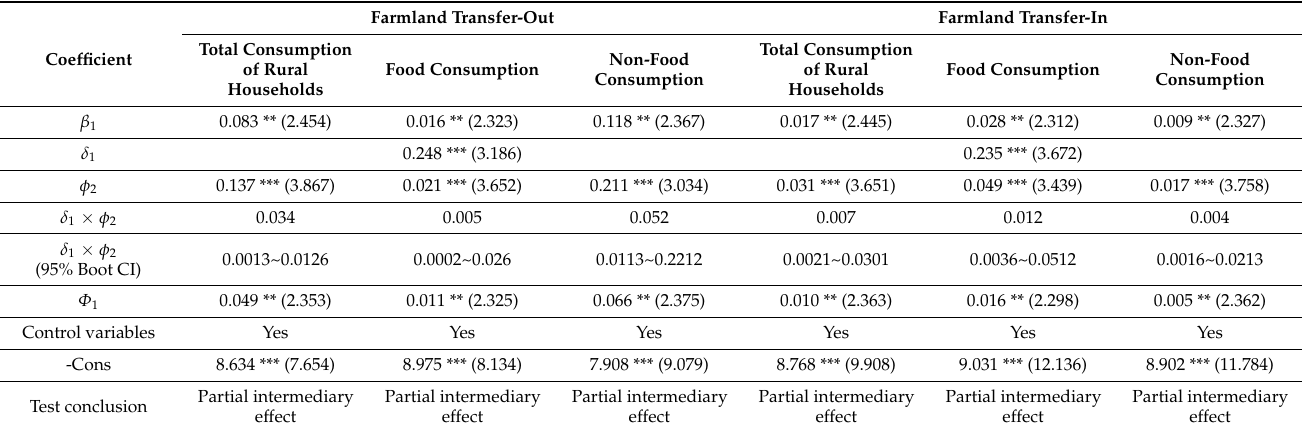
Table 9. Robustness test of intermediary